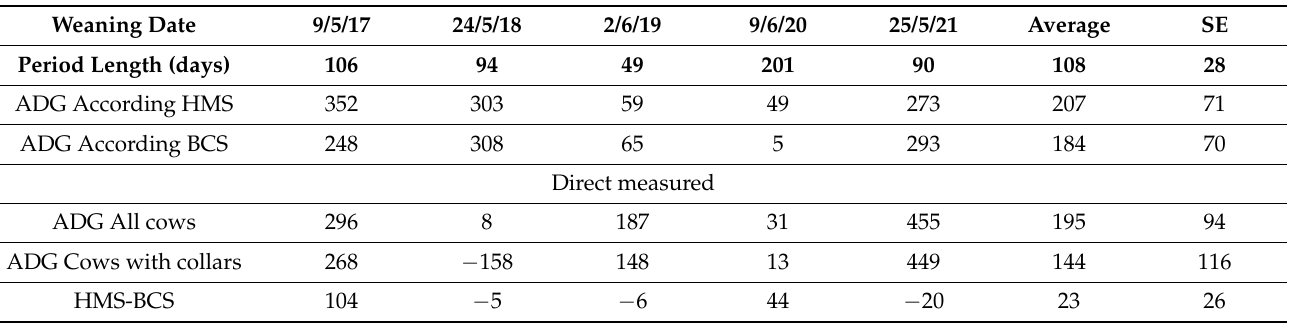
(Table 1): HMS to BCS t = 0.233, p = NS, r p = 0.991, p < 0.001; HMS to direct ADG collared cows t = 0.410, p = NS, r p = 0.067, p = NS; HMS to direct ADG all study cows t =